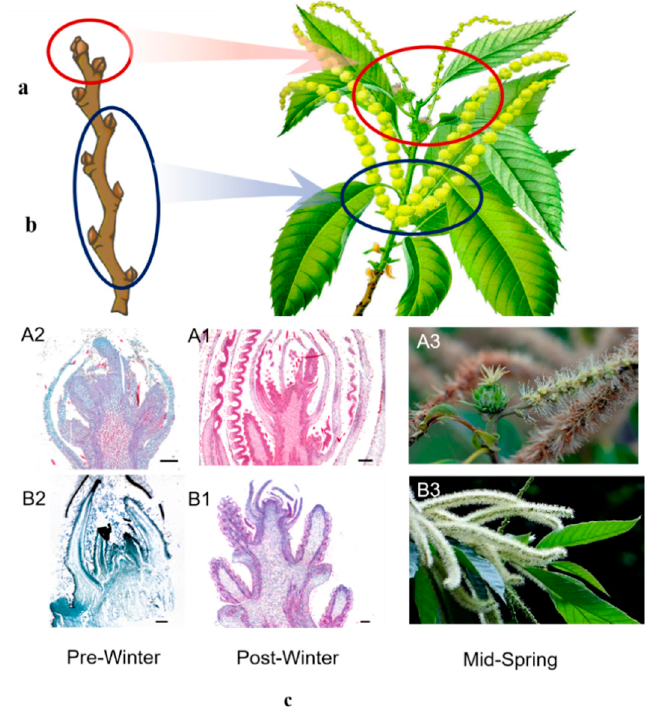
Figure 1. Slice diagram of chestnut flower bud in pre- and post-winter. Black bar represents 300 µ m. ( a ) Vegetative branch. The buds are arranged on the left and right sides to express the size and coverage of buds and bud scales in different parts; ( b ) Fruiting branch. The left and right pairs of small buds at the bottom are auxiliary buds, 1–4 are branch small buds, 5–16 are incomplete mixed flower buds, 15–16 are mixed flower buds, and 18–19 are large buds above the male inflorescence; ( c ) Two different mixed flower buds of Chestnut. A1 is the CMF post-winter. A2 is the CMF in pre-winter, and A3 is the CMF in flowering. B1 is IMF in post-winter. B2 is the IMF in pre-winter, and B3 is the IMF in flowering.